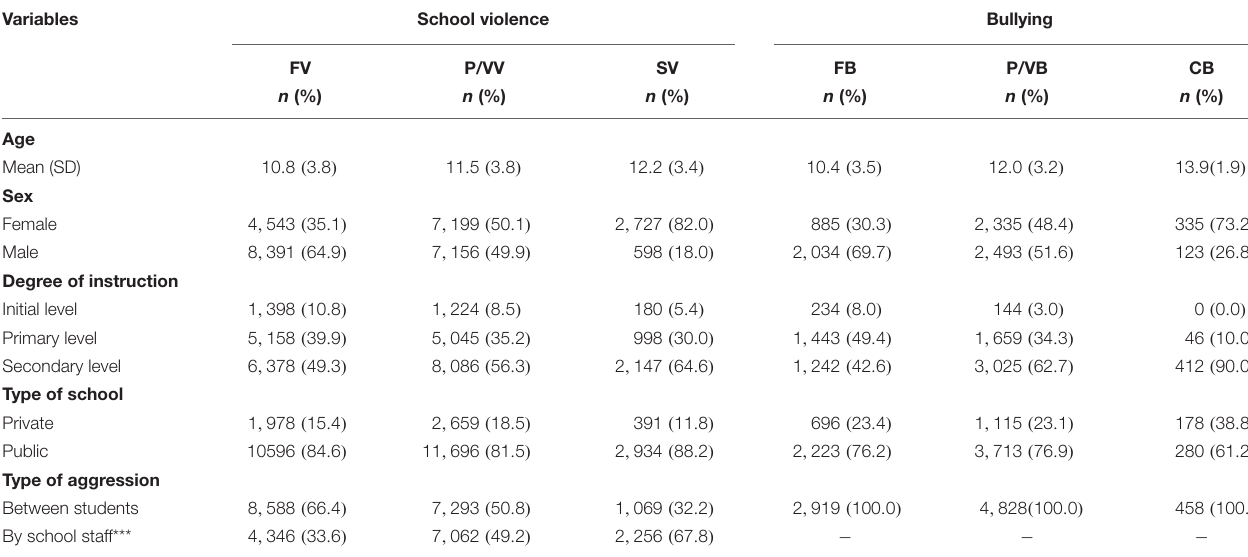
TABLE 2 | Types of bullying and violence according to sociodemographic and aggression characteristics in the 2014–2018 period.